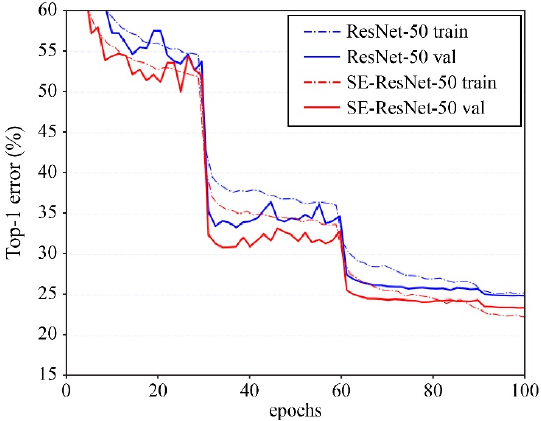
Figure 6. Training curves of ResNet-50 and SE-ResNet-50 on ImageNet (source: [22]).